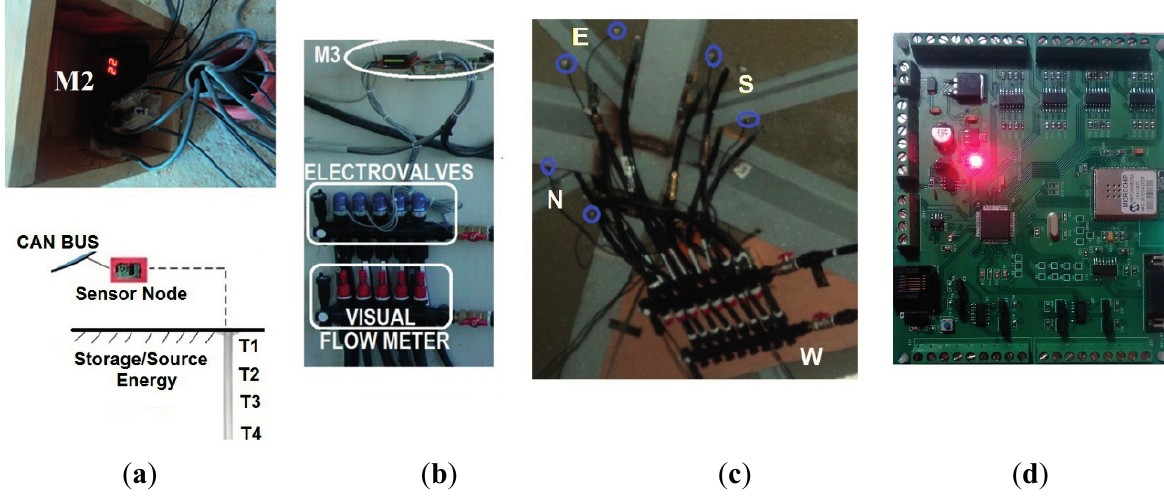
Figure 13. ( a ) M2 IoT node for underground temperature measurement; ( b ) M3 IoT node to control the opening/closing of the dynamic thermal barrier electro-valves; ( c ) Electro-valves at the ceiling; ( d ) M3 IoT sensor